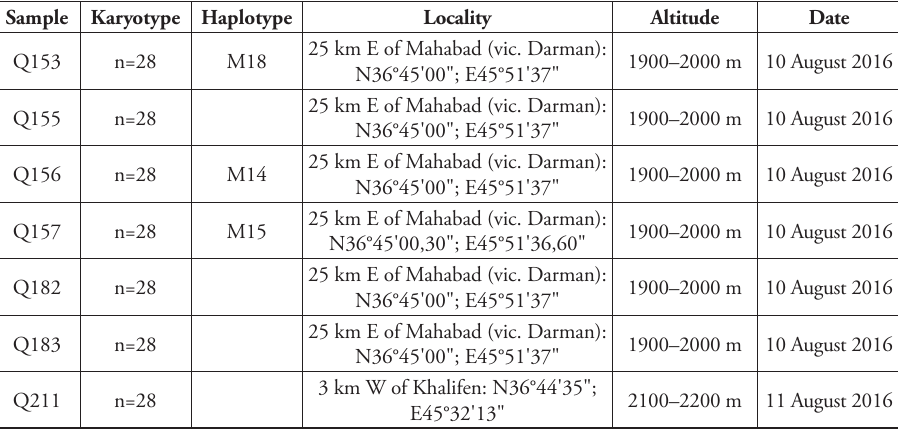
Table 1. Chromosome number and localities of Melitaea gina samples collected in Iran (province West Sample Karyotype